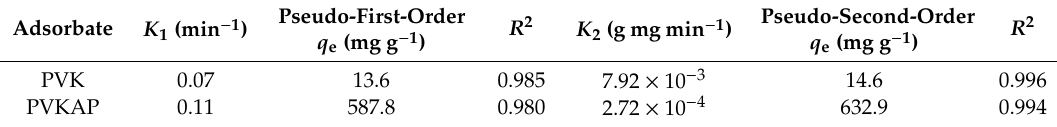
Table 4. Parameters for pseudo-first-order and pseudo-second-order models.